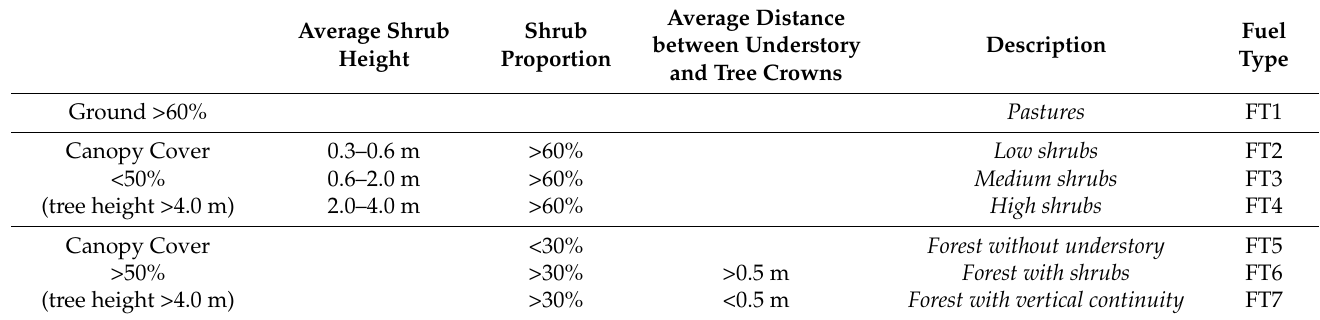
Table 1. Description of the different fuel types according to the Prometheus classification system